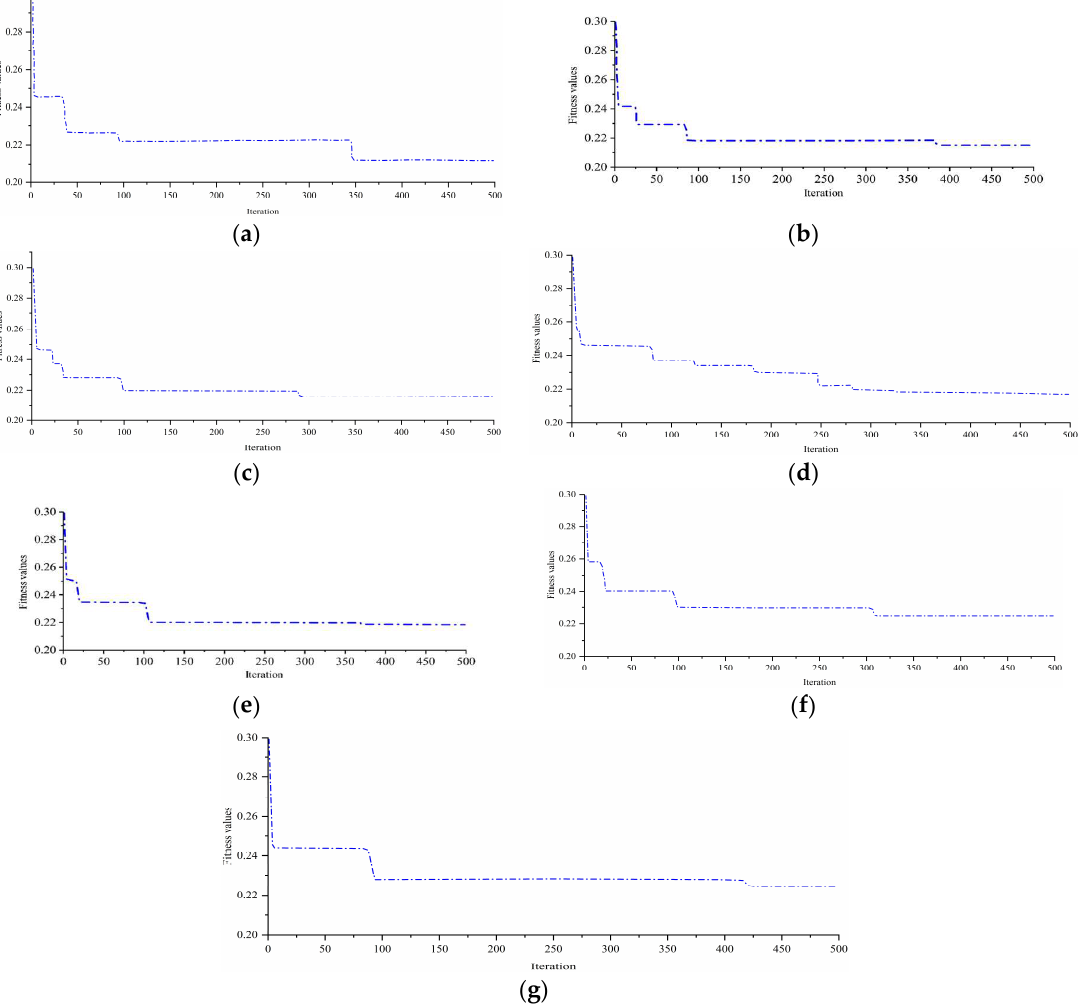
Figure 8. The effect of changing the AP values on CSA response. ( a ) AP = 0.1, ( b ) AP = 0.2, ( c ) AP = 0.3, ( d ) AP = 0.4, ( e ) AP = 0.5, ( f ) AP = 0.6, ( g ) AP = 0.7. Table 4. Performance evaluation index and calculation